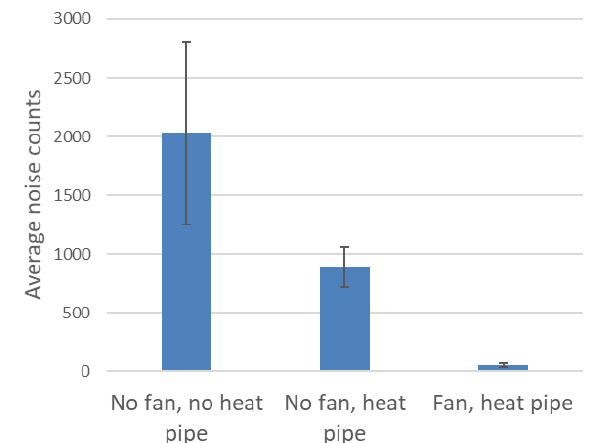
Fig. (cid:24). The average number of bright pixels (noise) in images produced by the CCD in (cid:24)-minute exposures with no source present at three different levels of cooling: no cooling, just the heat pipe, and heat pipe with a